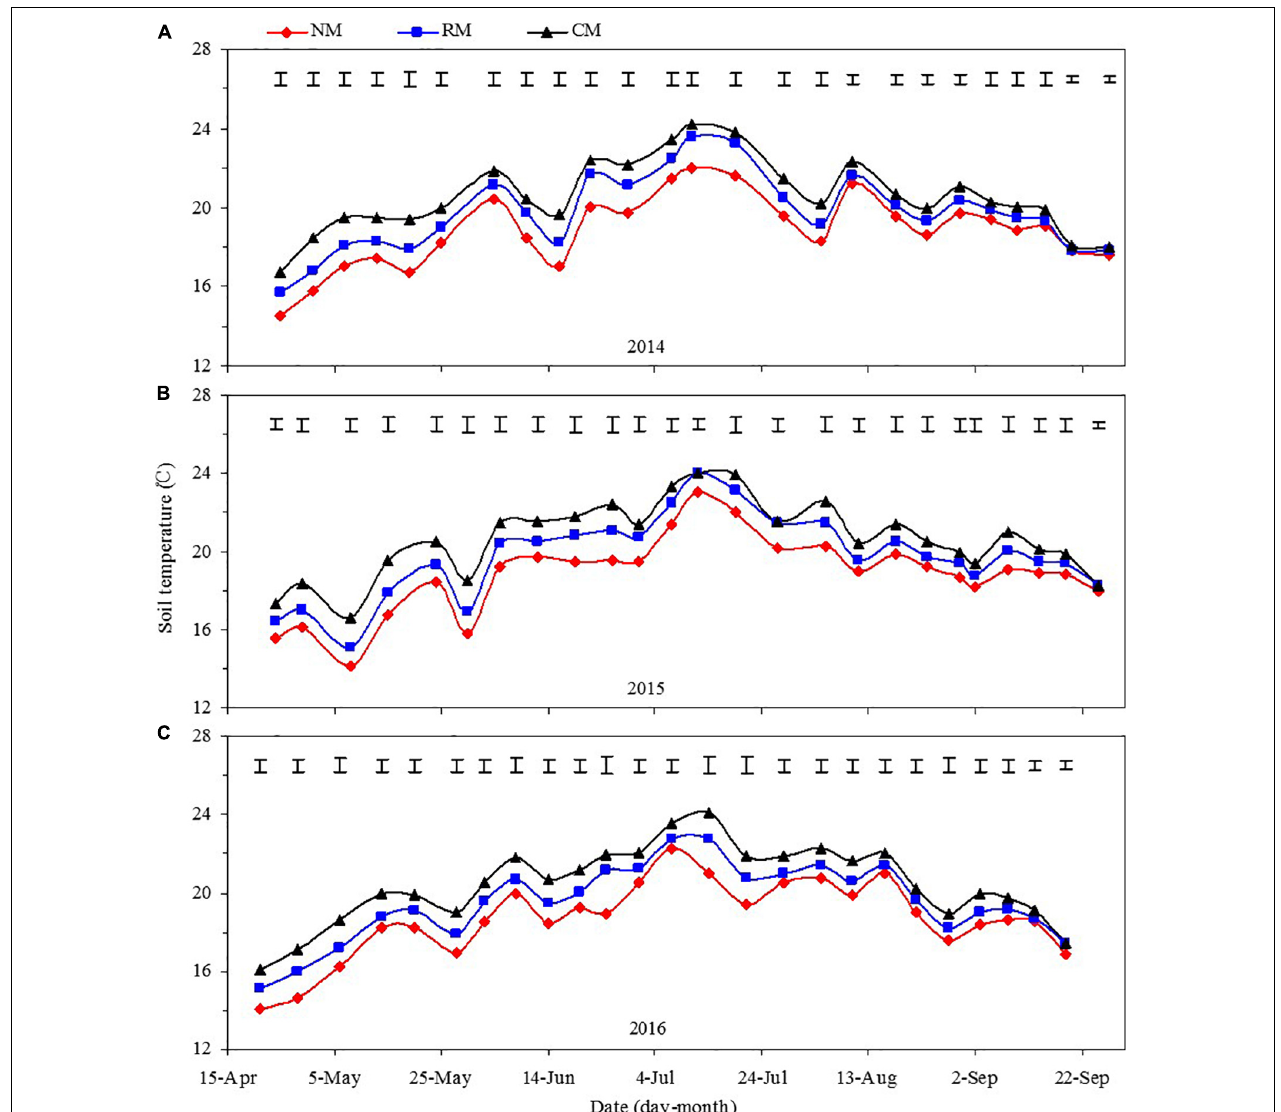
FIGURE 2 | Dynamics of soil temperature in the 5–25 cm soil layer in maize field as affected by plastic mulching practices across the entire growing season in 2014 (A) , 2015 (B) , and 2016 (C) . NM, no tillage with plastic re-mulching; RM, no tillage with plastic mulching after maize was harvested in autumn and new plastic was mulched in next spring after the old plastic was removed off the field and rotary ploughed; CM, conventional deep tillage (the depth is 30 cm) after maize was harvested and the old plastic was removed off the field in autumn, and new plastic was mulched in next spring before maize sowing. The length of vertical bars represents the magnitude of the least significant difference (LSD) at P = 0.05 among treatments within a measurement date. NS, no significant difference at the 0.05 probability